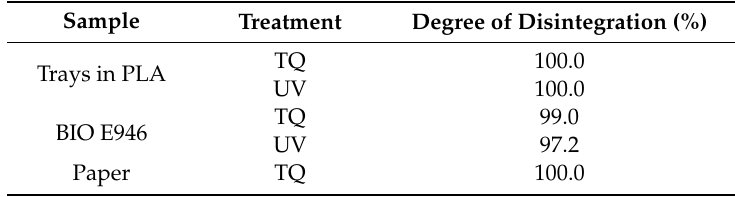
Table 5. Degree of disintegration of PLA and BIO E946, UV treated and not